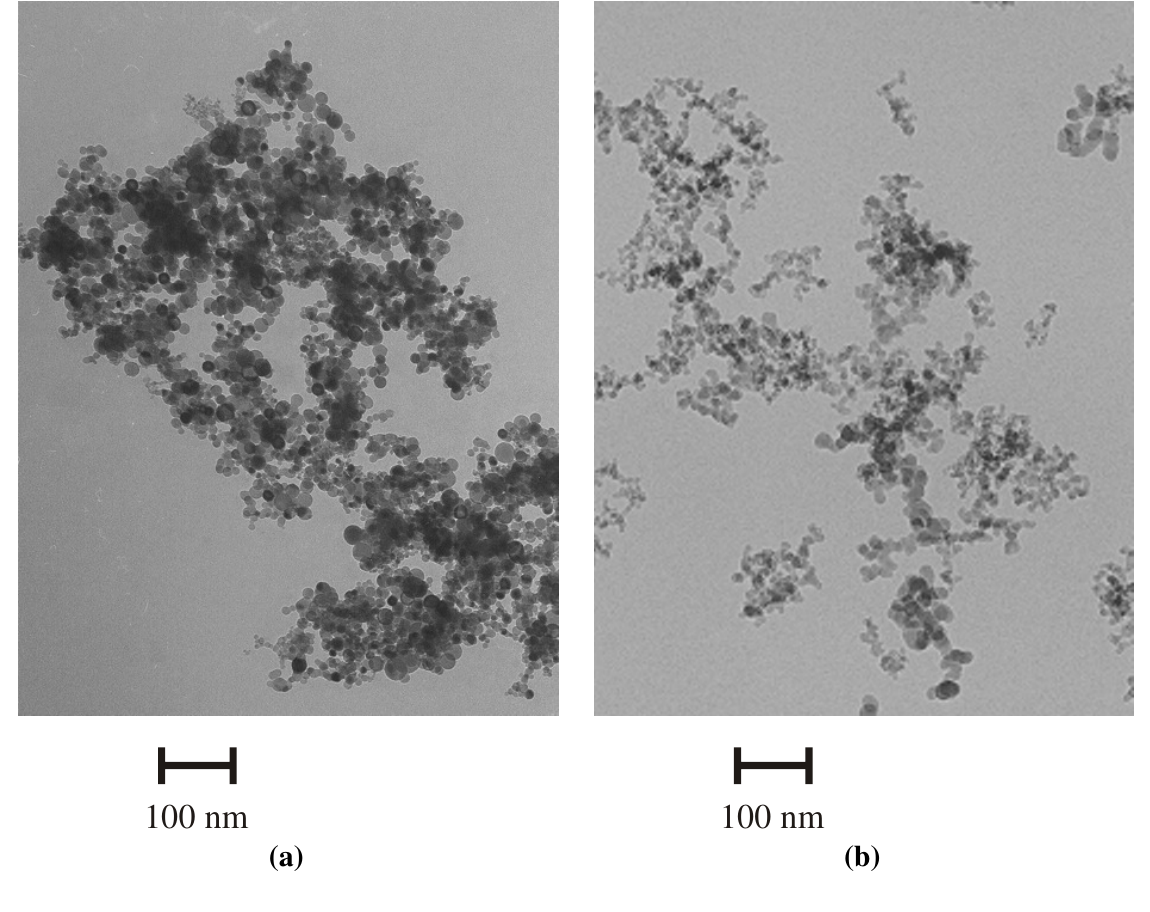
Figure 1. Electron micrographs of ( a ) SiNPs; and ( b ) SiO